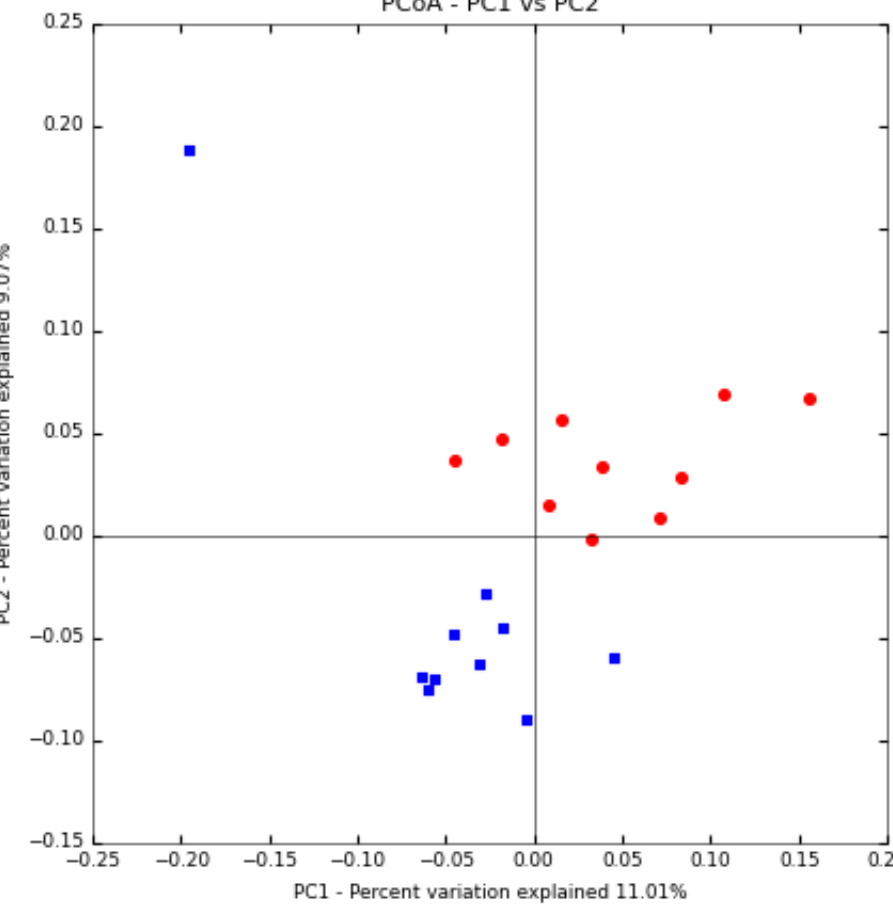
Figure 4. Principal coordinate analysis. Blue dots are for male samples and red dots for females.